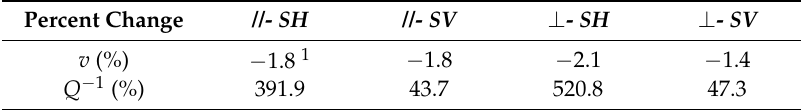
Table 2. The percent change of S-wave velocity and attenuation during stage iii and iv.